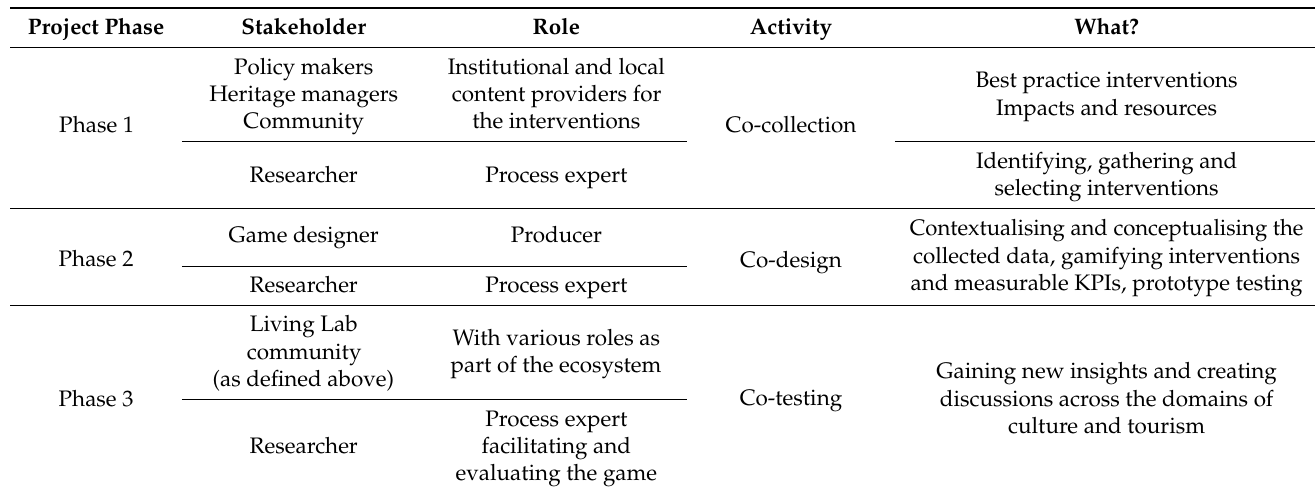
Table 5. Contributors to the development of